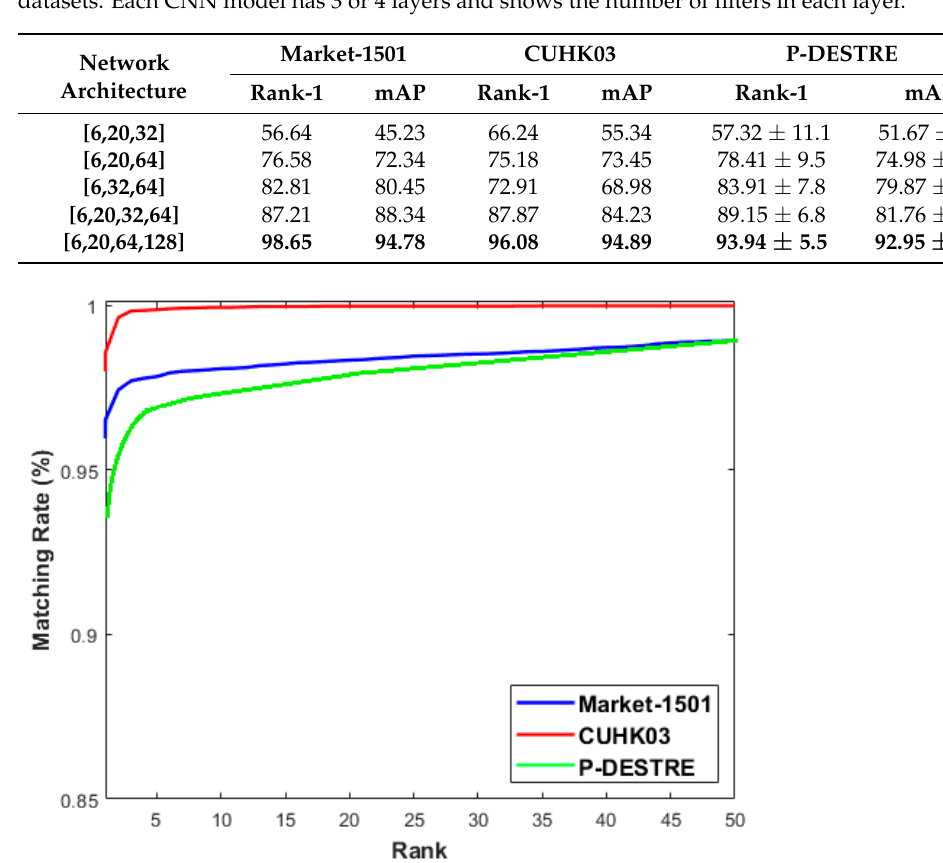
Figure 8. CMC curves for the best trained CNN model over three different ReID datasets.